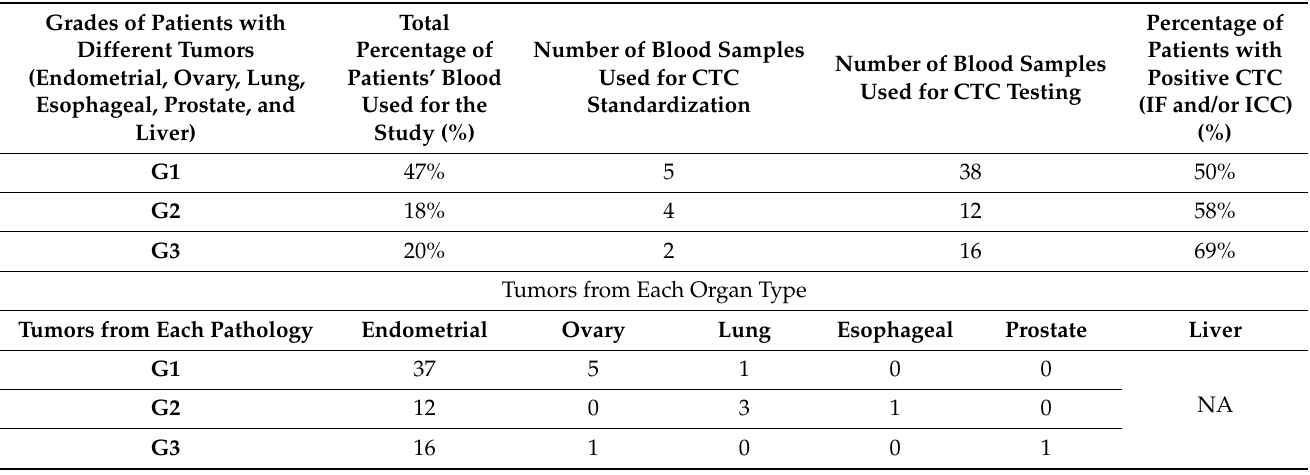
Table 4. Grade-wise distribution of patients’ blood samples used for the standardization and testing of CTCs, along with tumors from each